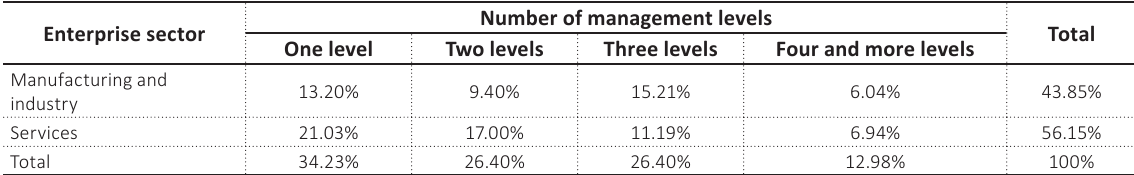
Table 3. Dependence between the number of management levels and sector affiliation